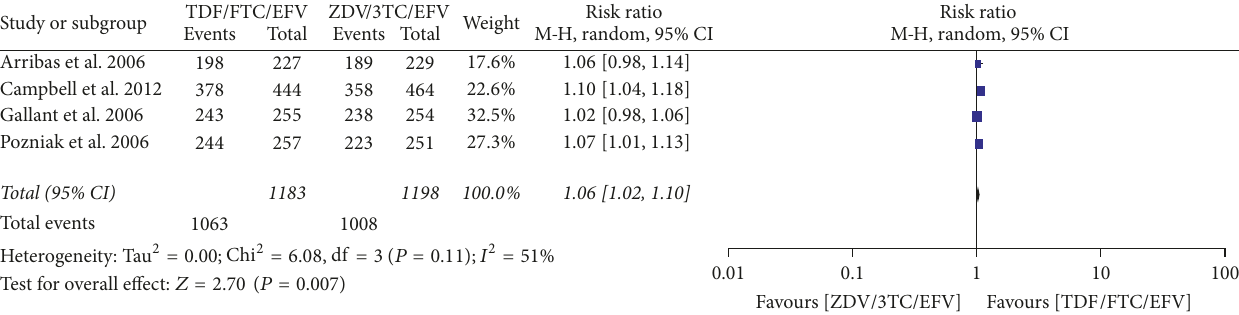
Figure 5: Forest plot of tolerability of TDF arm as compared to ZDV arm in ART na¨ıve HIV-1 infected patients.